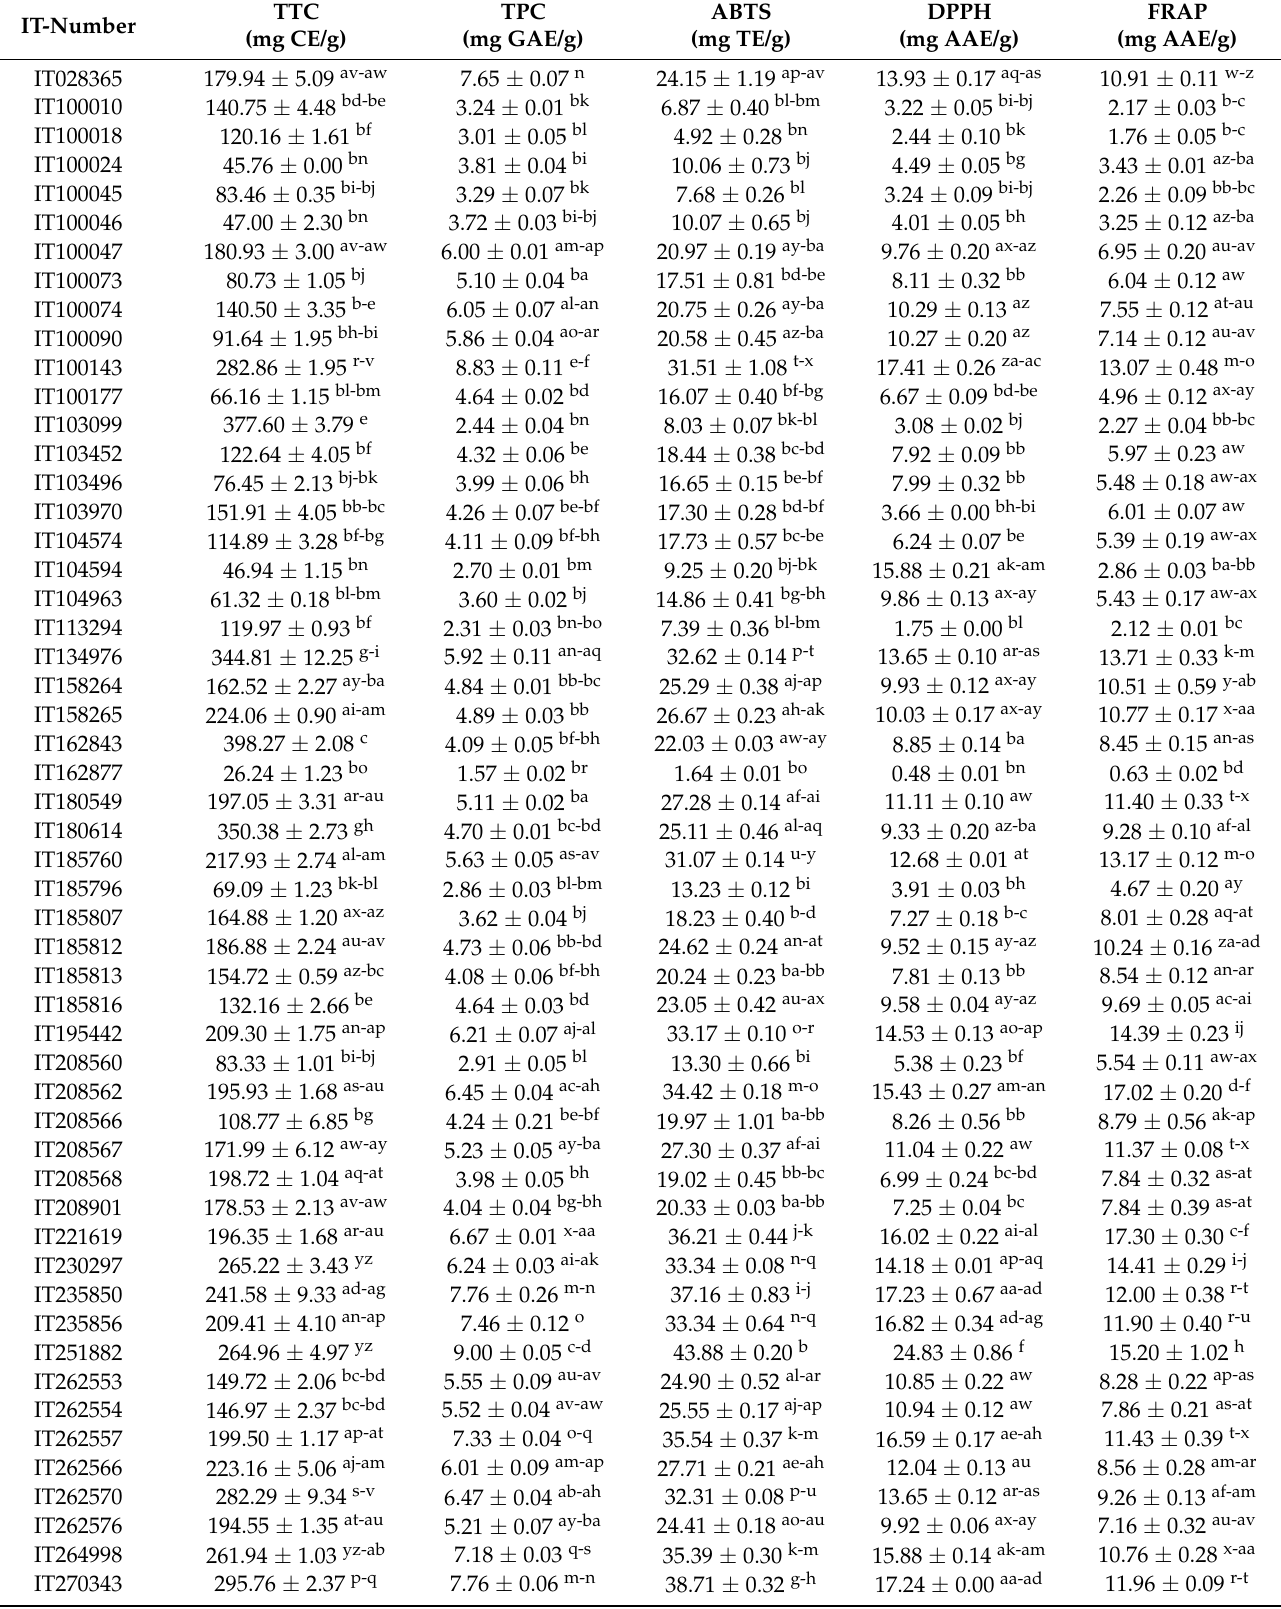
Table 2. Total metabolite contents and antioxidant activities of sorghum